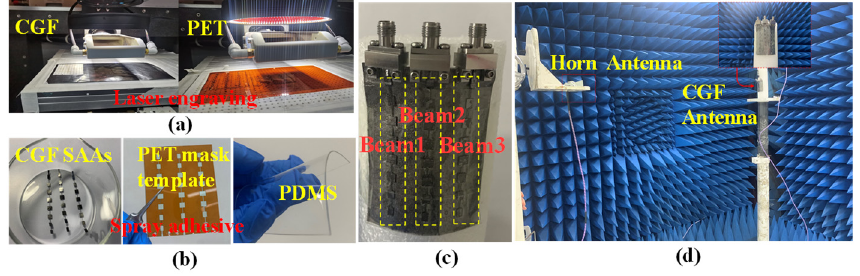
Figure 4. Fabrication process of the CGF antenna: ( a ) laser engraving and ( b ) photolithographic samples; ( c ) the prototype; ( d ) anechoic chamber measurement environment.